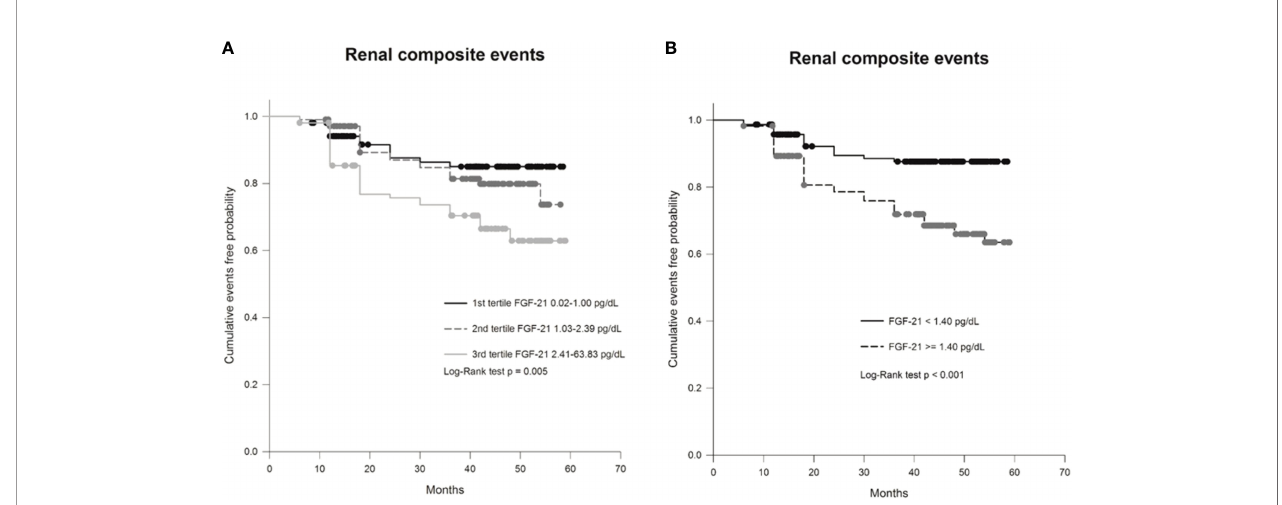
FIGURE 3 | Kaplan-Meier curve showing the probability of cumulative event-free survival of renal events (either or both a decline of >30% in eGFR and worsening stage of albuminuria) in (A) patients with type 2 diabetes (T2DM) divided into groups based on concentration tertiles of FGF-21 levels and in (B) patients with T2DM grouped based on a speci fi c cut-off value of FGF-21 ( ≥ 1.40 pg/dL vs. < 1.40